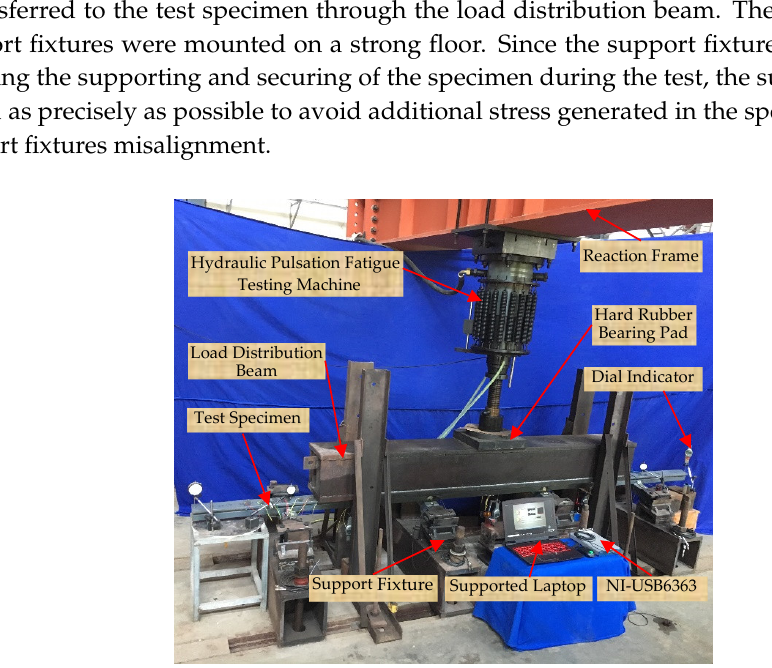
Table 2. The details of PZT transducers in the test specimen.